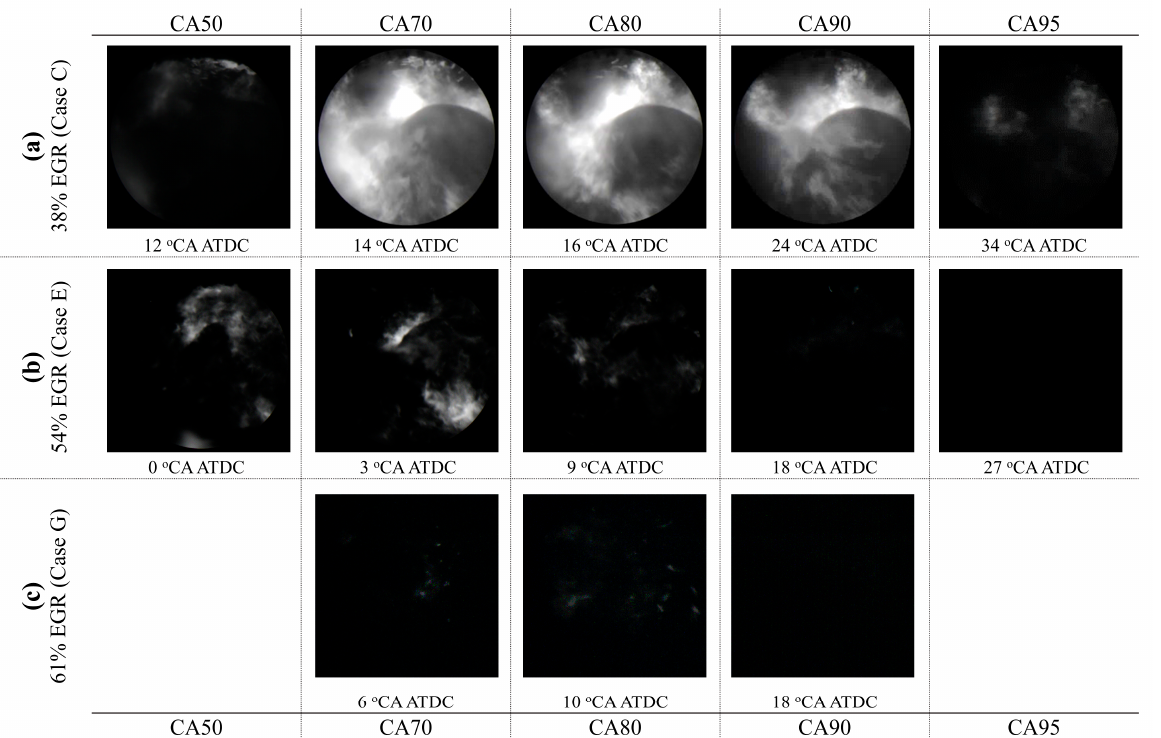
Figure 4. 10 cycle average flame images at low-load condition (8 mg/cycle fueling quantity); ( a ) Case C—Intermediate EGR combustion at − 3 °CA ATDC SOI (images used as recorded); ( b ) Case E—High-EGR LTC at − 21 °CA ATDC SOI (images are intensified) ( c ) Case G—High-EGR LTC at − 24 °CA ATDC SOI (images with maximum intensification).